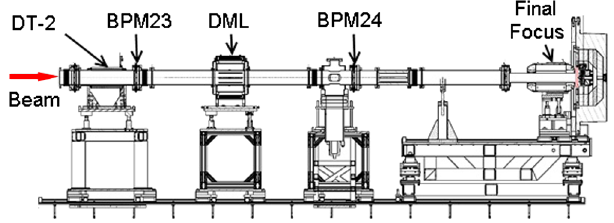
FIG. 5. DML installation in DARHT-I downstream